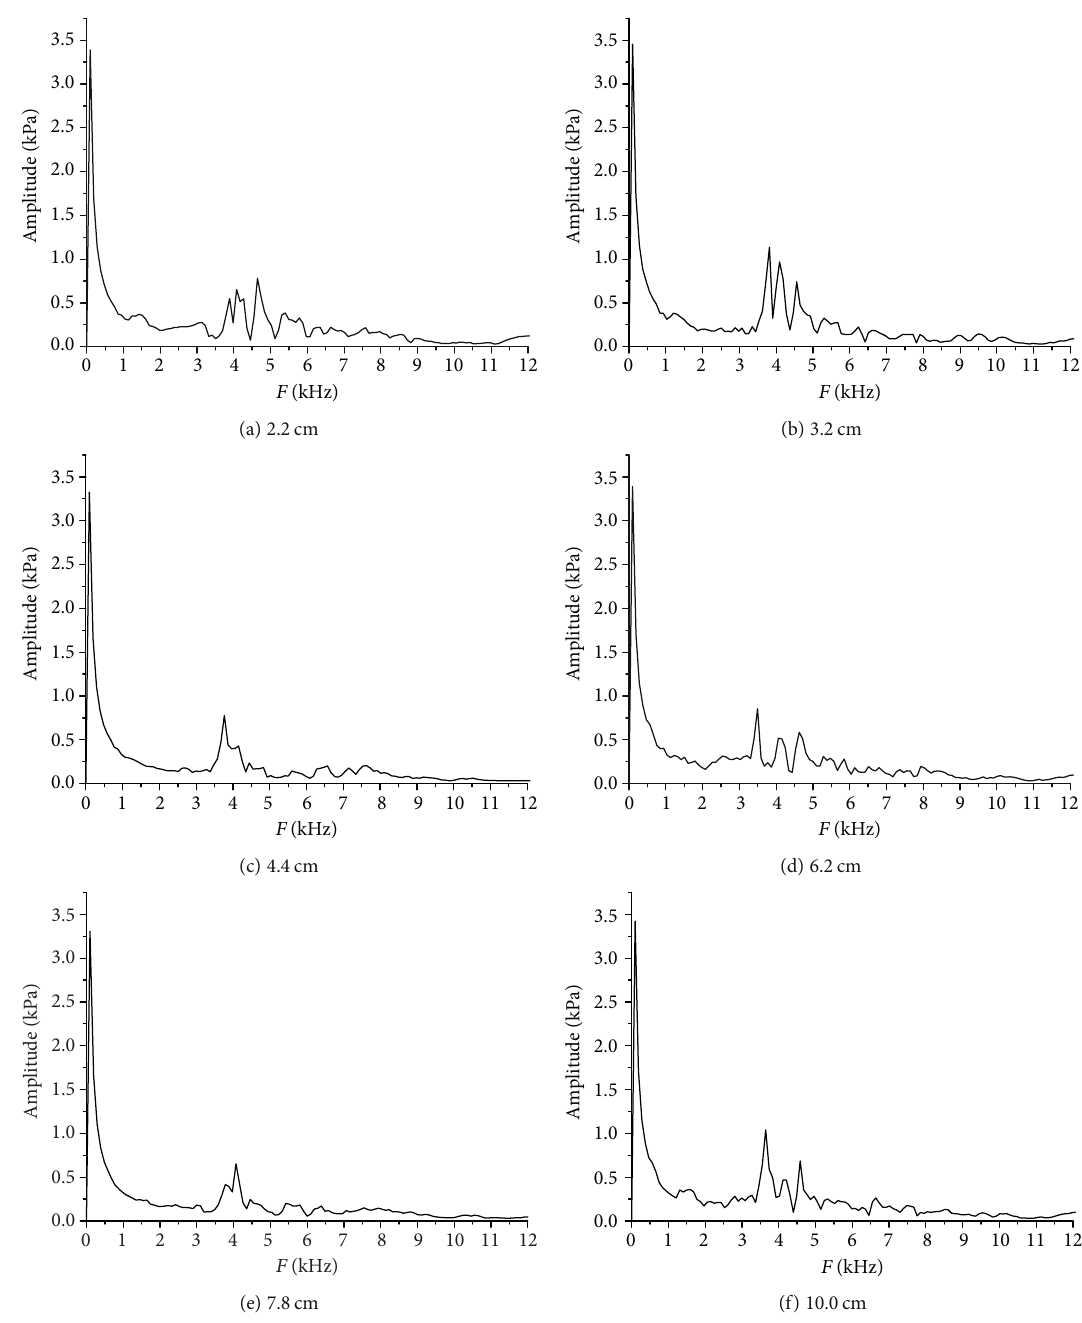
Figure 7: FFT analysis of pressure oscillations at the observation point for the Model C chamber with di ff erent injector